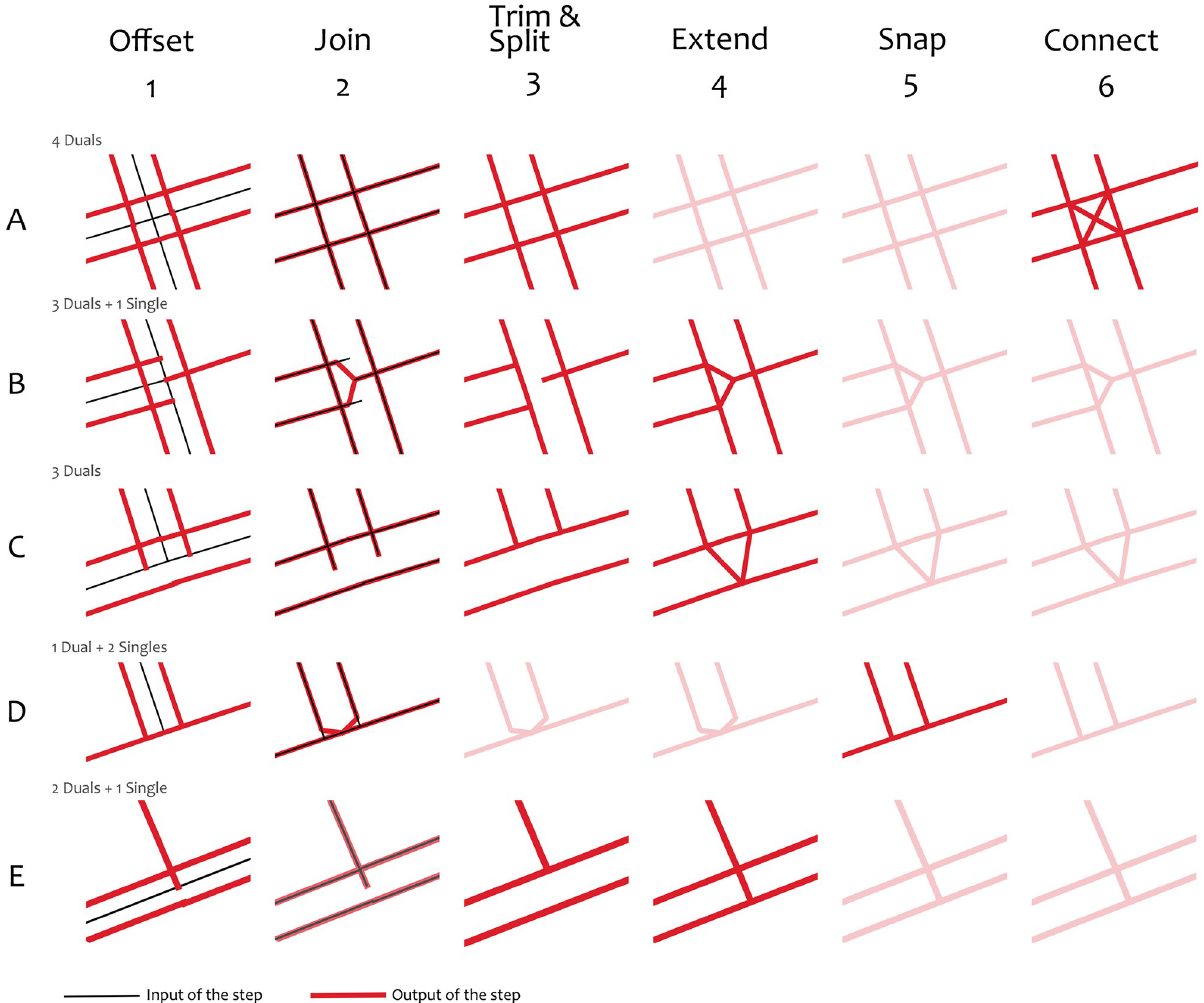
Fig 6. Common intersection types in linear networks and their state during the six iterations of our methodology. The rows represent 5 different cases (taken from OSM). Note : the inputs of steps 3 through 6 are omitted for the matter of